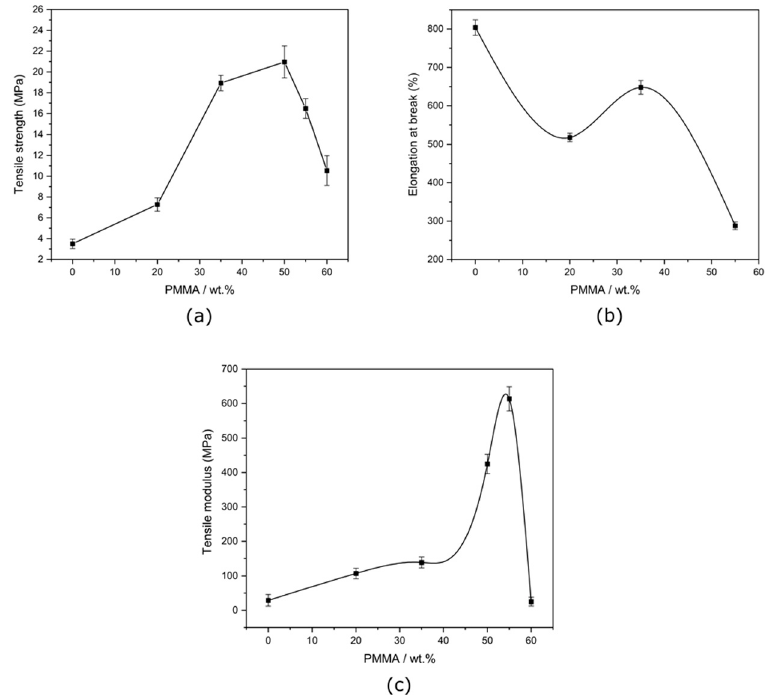
Figure 7. The effect of PMMA concentration in crosslinked semi-IPNs on ( a ) tensile strength, ( b ) elon- gation at break, and ( c ) tensile